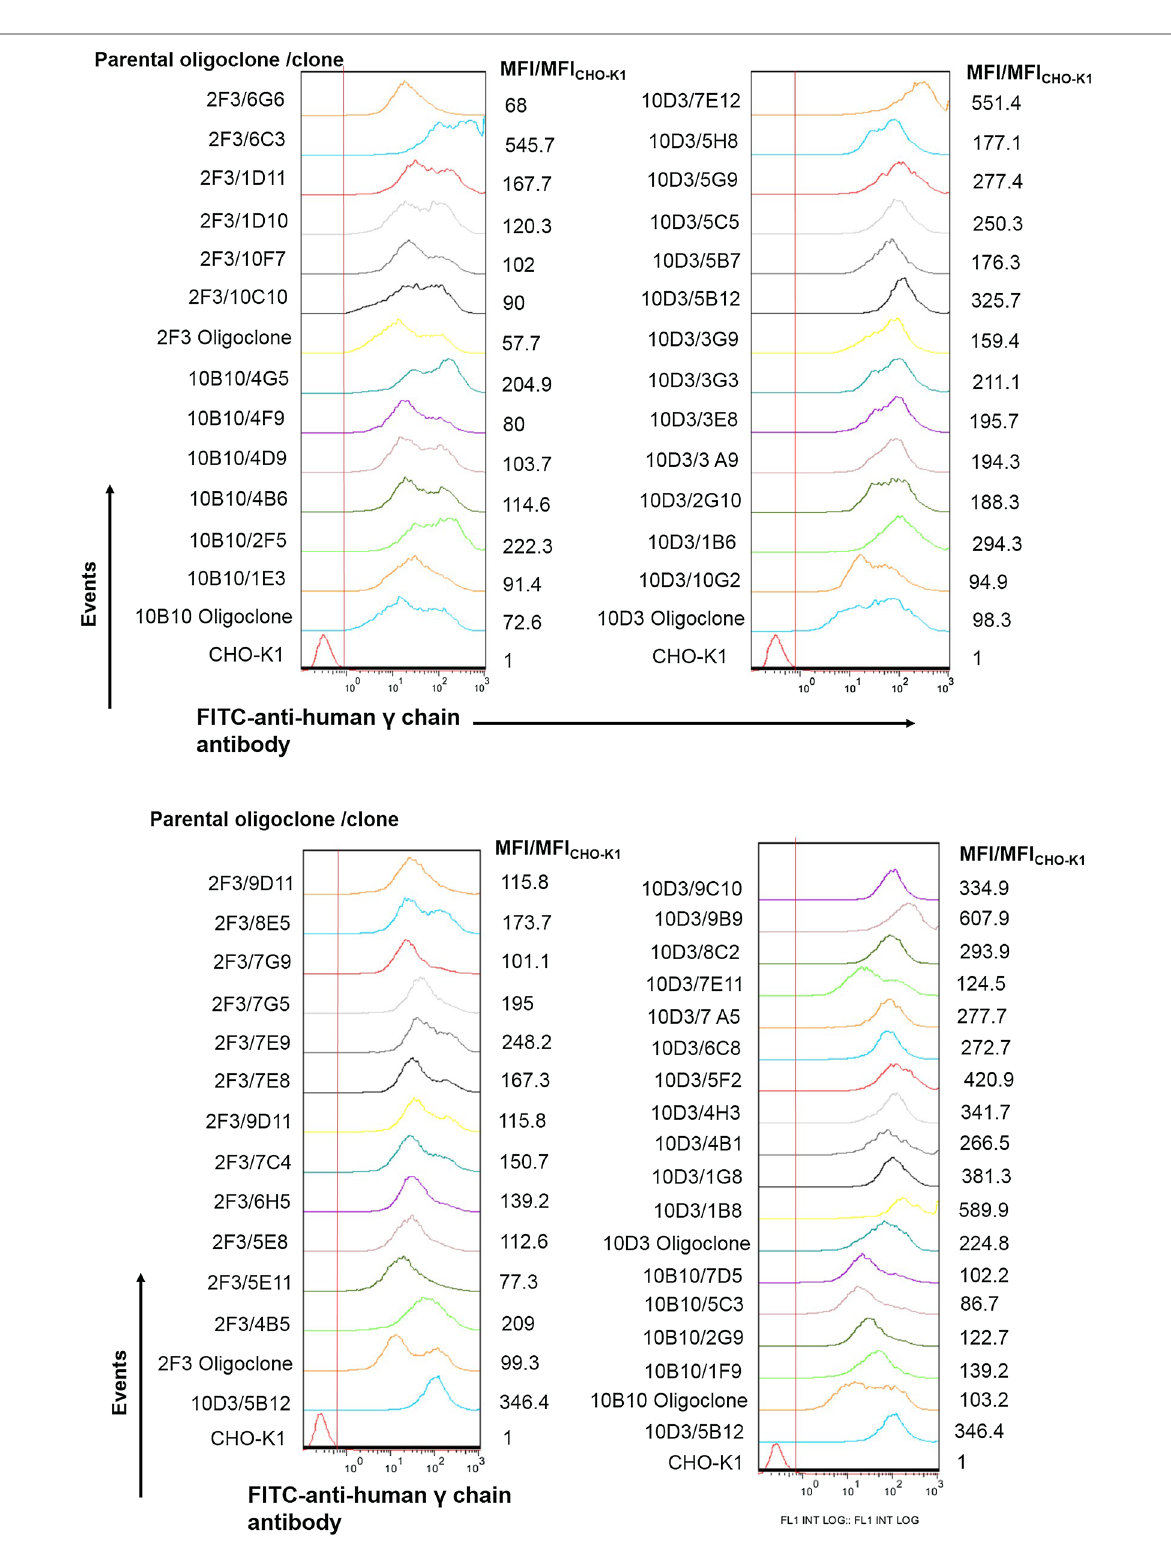
Fig. 6 Assessment of heavy chain polypeptide content of cell clones by flow cytometry. Intracellular heavy chain polypeptides of ethanol fixed cells were measured using a FITC‑labeled goat anti‑human IgG (γ chain specific) antibody. MFI/MFI CHO‑K1 : mean fluorescence intensity of trastuzumab‑expressing cells compared to the mean fluorescence intensity of CHO‑K1 wild type cells